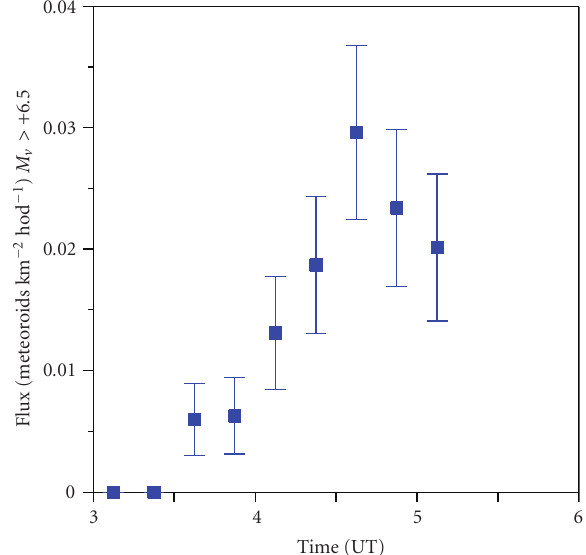
Figure 6: Flux of the meteoroids per km 2 per hour as detected at the Kunˇzak station during the 2006 Leonid